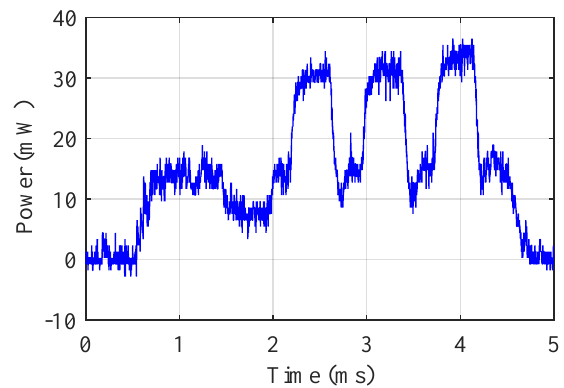
Figure 7. Power profile of SPW-2 when transmitting a triple BLE advertisement at 5 dBm.